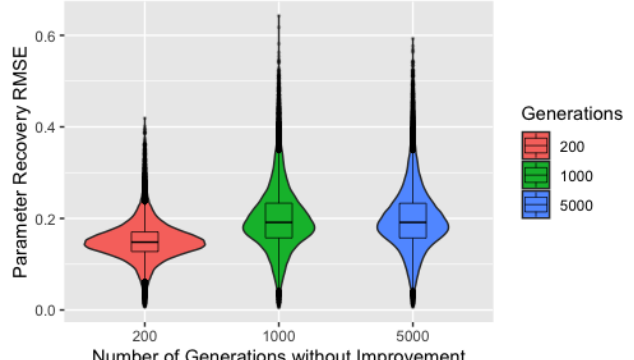
Figure 3. Boxplots and violin plots for root-mean-square-error for recovery by number of generations without improvement for runs that identified a solution with 1000